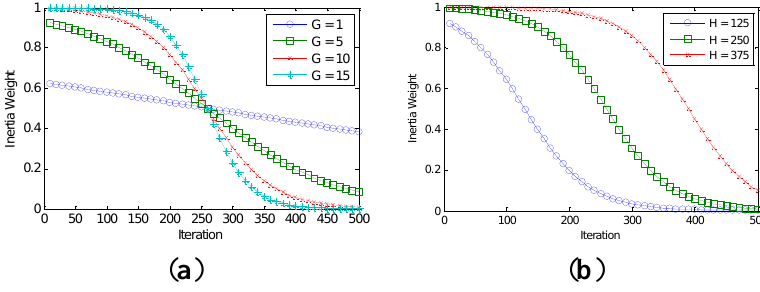
Figure 1. ( a ) Effect of tuning parameter G; ( b ) Effect of tuning parameter H.